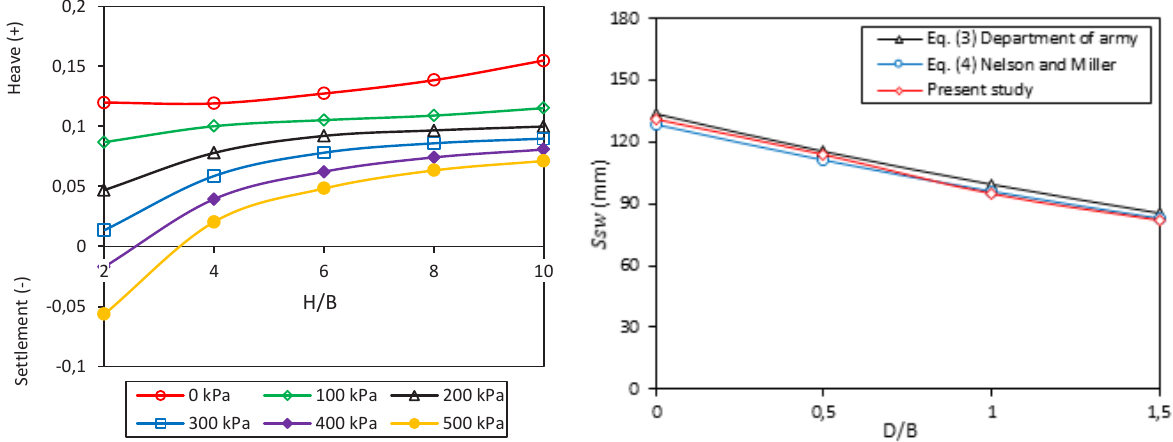
after swelling for sw =0 to 500 kPa. 0